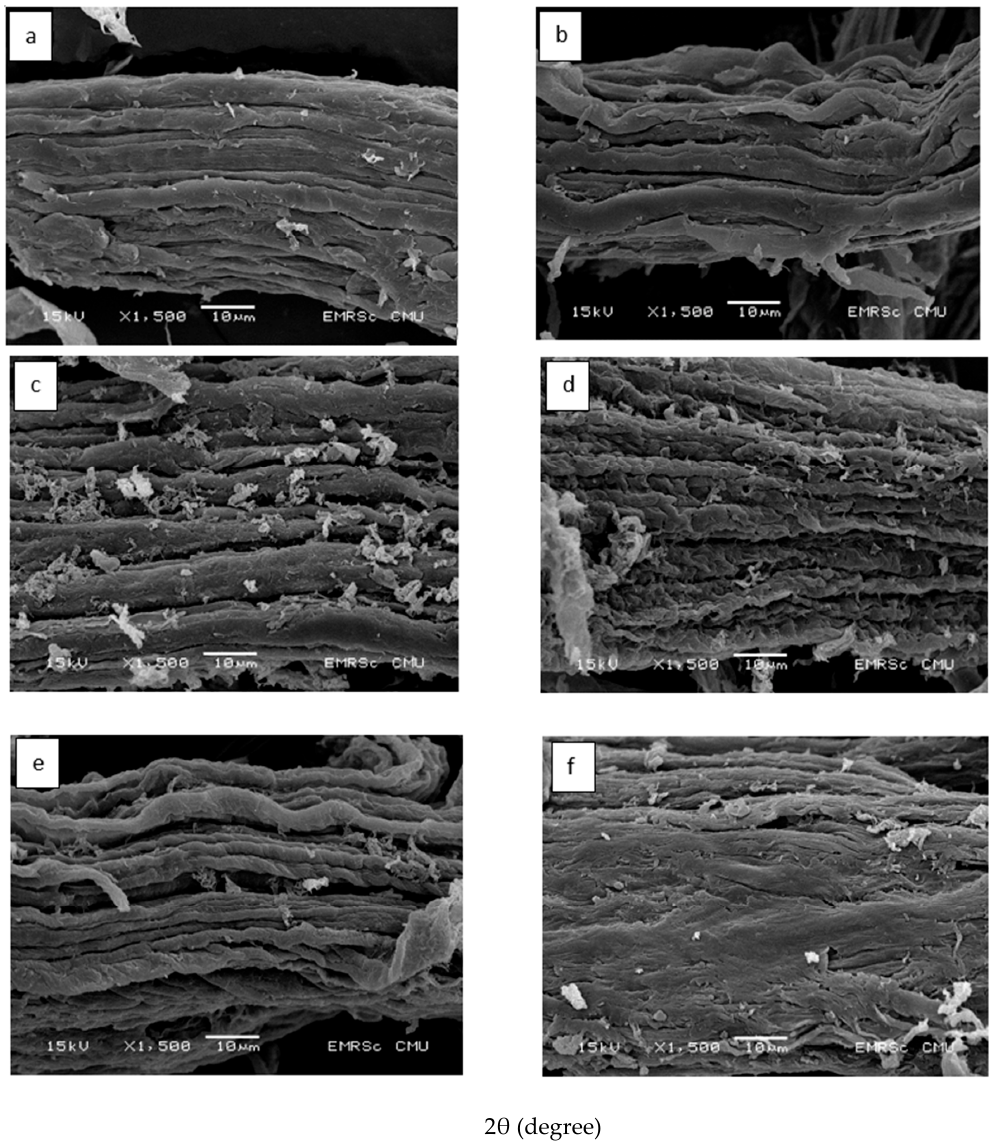
Figure 7. Scanning electron micrographs of ( a ) cellulose from asparagus stalk end and cmc as powder: with ( b ) 20% ( w / v ) naoh, ( c ) 30% ( w / v ) naoh, ( d ) 40% ( w / v ) naoh, ( e ) 50% ( w / v ) naoh and ( f ) 60% ( w / v ) naoh. The acceleration voltage was 15 kv under low with 1500×.